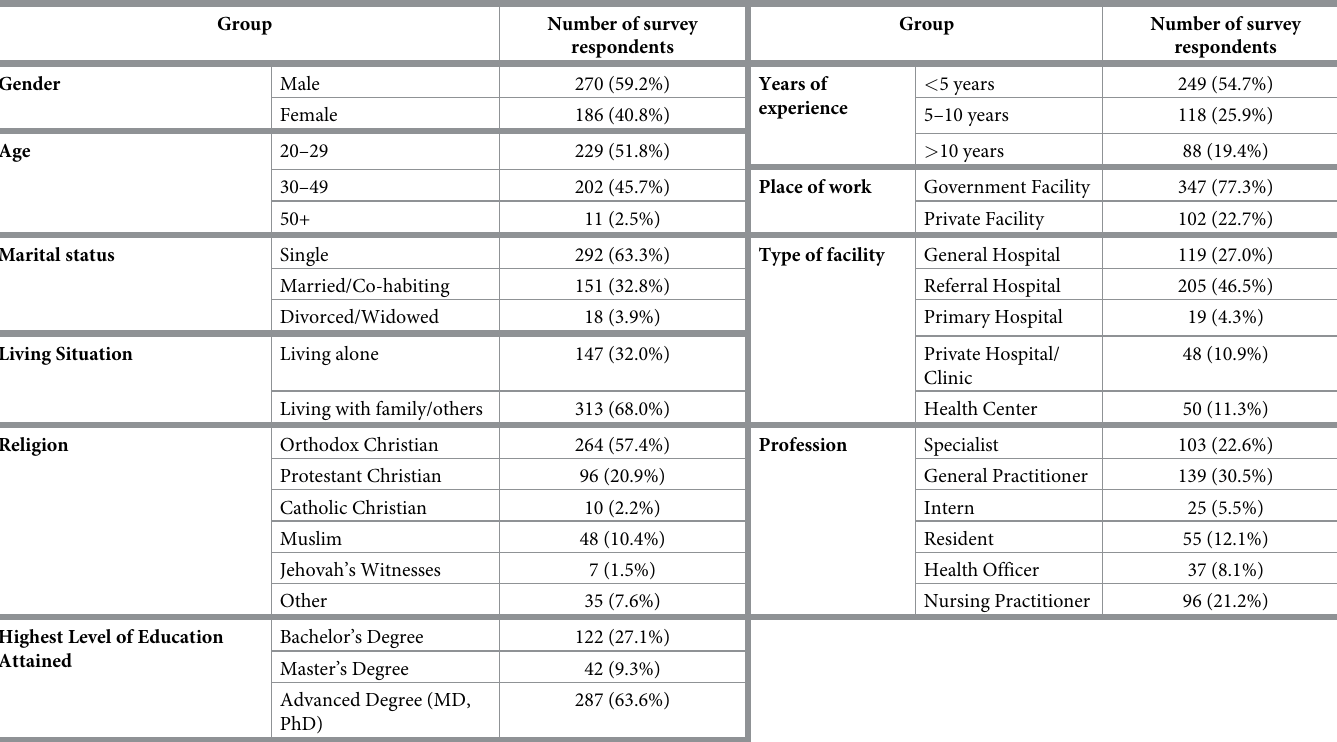
Table 1. Demographic groups of our survey participants for the